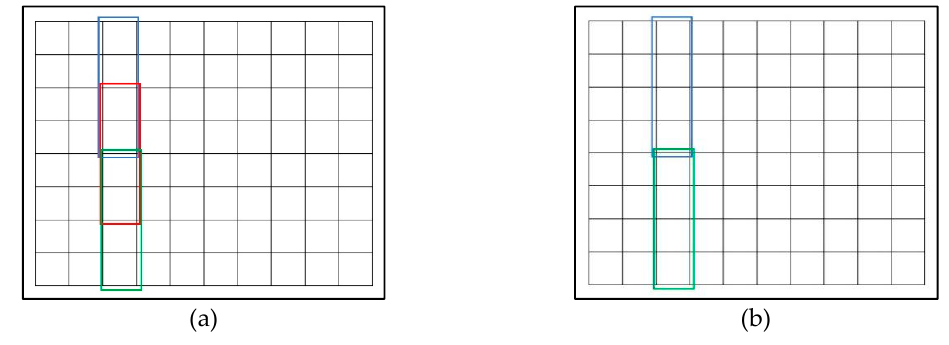
Figure 11. Schematic diagram of a sliding window and a jumping window: ( a ) 4 × 1 sliding window with 50% overlap in the longitudinal direction and no overlap in the lateral direction; ( b ) 4 × 1 jumping window (without overlapping in either direction).